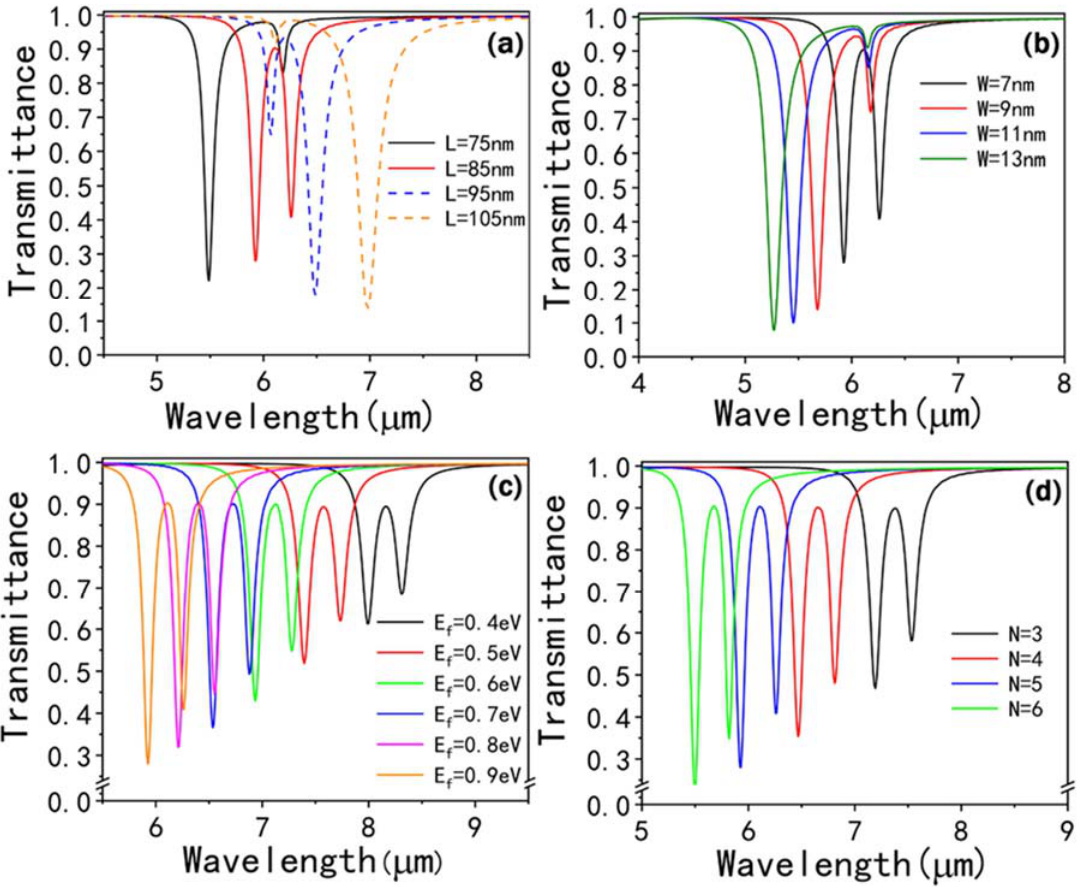
Figure 6. The transmission spectra of the PIT metasurface with different ( a ) L, ( b ) W, ( c ) and ( d ) N.